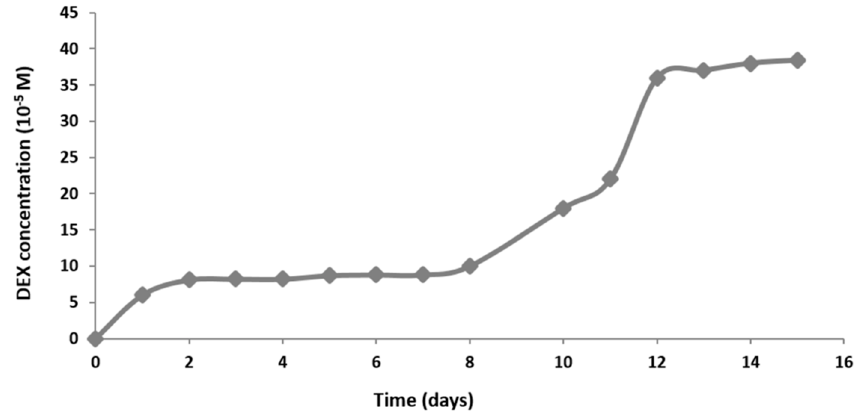
Figure 2. Concentration of DEX released to phosphate buffered saline (PBS) from RADA 16-I peptide hydrogel mixed with 4 × 10 − 3 M DEX in the parallel system of a perfusion bioreactor, measured each day for 15 days. Measurements were obtained by UV-Vis spectrophotometry.